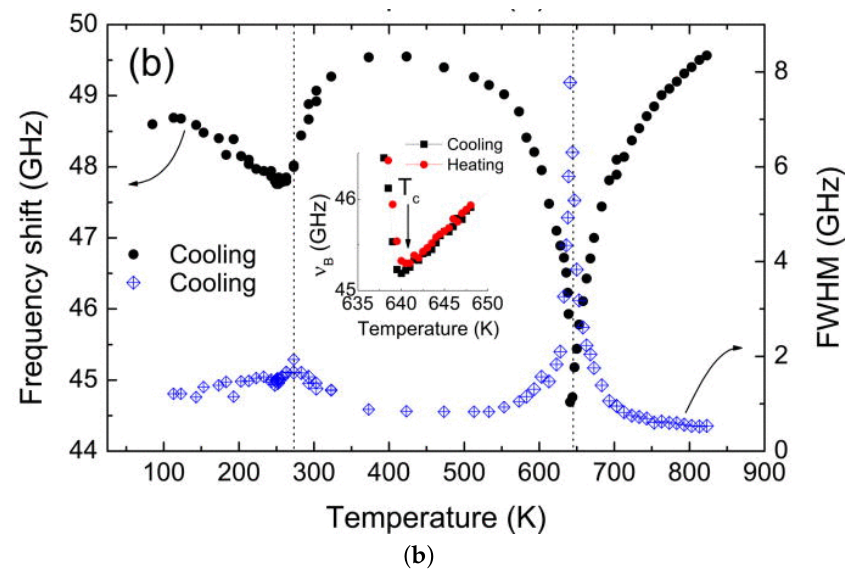
Figure 14. The temperature dependences of the Brillouin frequency shift and the FWHM of the LA mode, corresponding to c 11 , for ( a ) PZT-45; and ( b ) PZT-42. The insets show the extended view of the minimum of the Brillouin frequency shift of each sample. (from Ref. [53], Copyright American Institute of